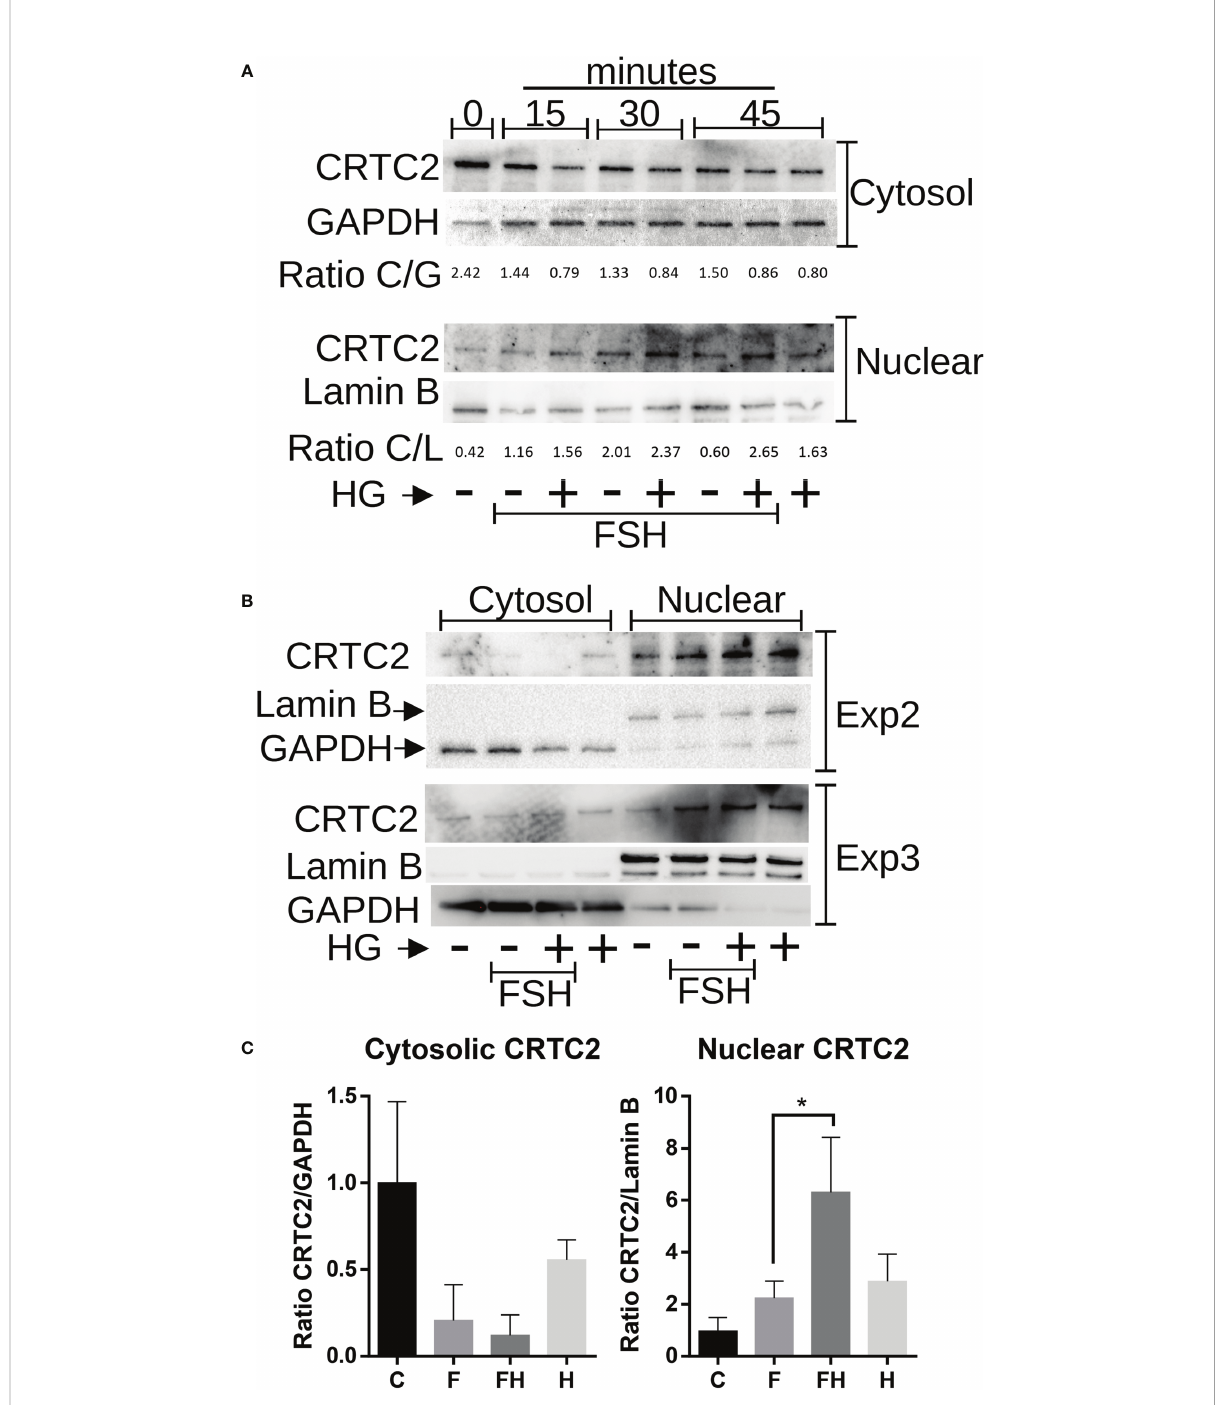
FIGURE 9 Effect of FSH and SIK inhibition on the subcellular localization of CRTC2. (A) Rat GCs were treated with FSH (50 ng/ml) in the presence or absence of HG (0.5 µM) for 15, 30, or 45 minutes or left untreated. (B) Rat GCs were treated with FSH in the presence or absence of the SIK inhibitor HG for 45 minutes. For A and B, Nuclear and cytosolic extracts were prepared and blotted for CRTC2, GAPDH (cytosolic marker), or Lamin B (nuclear marker). The bands were quanti fi ed using Image J software, and the ratio between CRTC2 and the corresponding subcellular marker was calculated. (C) Cytosolic and Nuclear CRTC2 content as a ratio to the corresponding subcellular marker is plotted. *p <0.05, n =